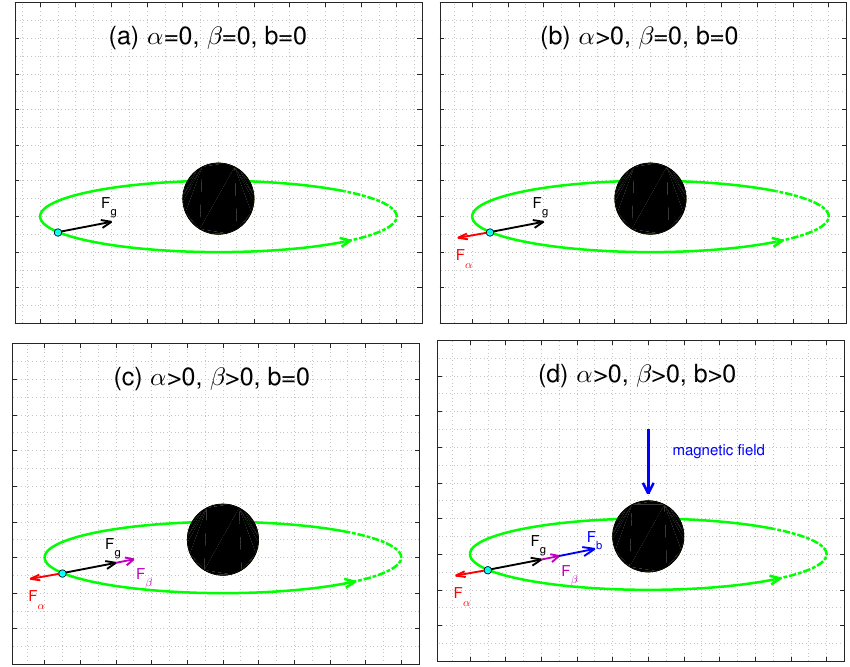
Figure 5. Representation of the force responding to the parameters. Case ( a ) refers to a test particle moving around Schwarzschild black hole, and the particle only suffers gravity F g from the central object. Case ( b ) refers to the Schwarzschild black hole with a cosmological background, and repulsive force F α is the resultant action from the gravity of galaxies and galaxy groups or clusters. Case ( c ) considers the appearance of dark matter, and force F β is an effect of the gravitational force of dark matter. Case ( d ) describes the spacetime immersed in an axially magnetic field, and Lorentz force F b acts on charged particle